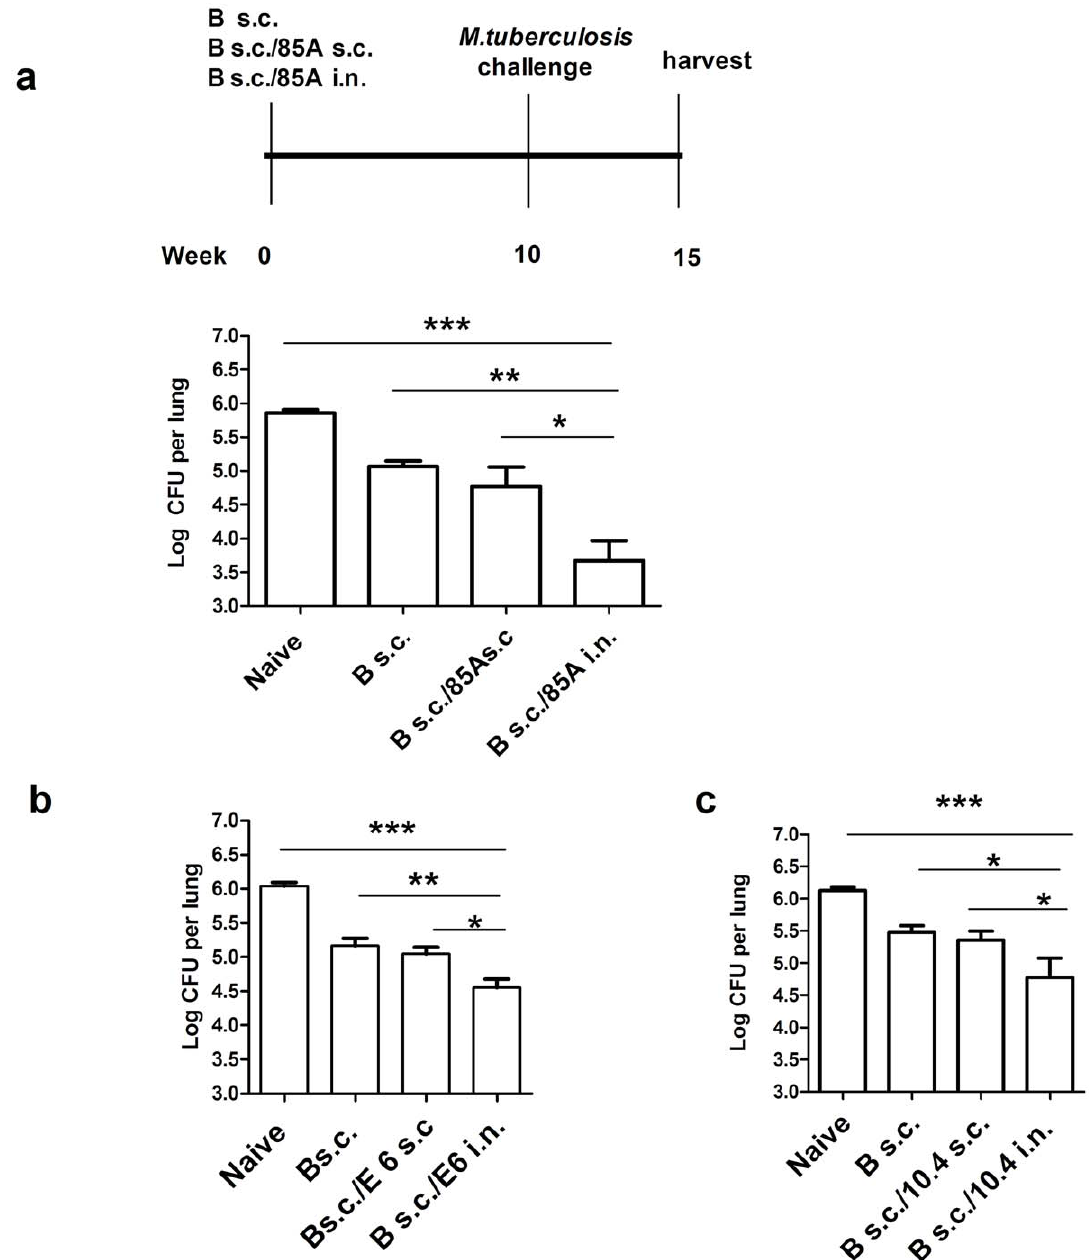
Figure 1. Mtb cfu after SIM with BCG and subunit vaccines. a. C57BL/6 mice were immunized once with BCG with or without simultaneous administration of 85A s.c. or 85A i.n., or b, once with BCG with or without simultaneous administration of E6 s.c. or E6 i.n. and c, once with BCG with or without simultaneous administration of 10.4 s.c. or 10.4 i.n.. Ten weeks after the last immunization they were challenged with Mtb i.n. and a further 5 weeks sacrificed later for enumeration of lung Mtb cfu. Representative data from one of two experiments with 5–7 mice/group are shown. ***p , 0.001, **p , 0.01, * p , 0.05 between the indicated groups, one-way ANOVA with Tukey’s post test. Data are means 6 s.e.m.